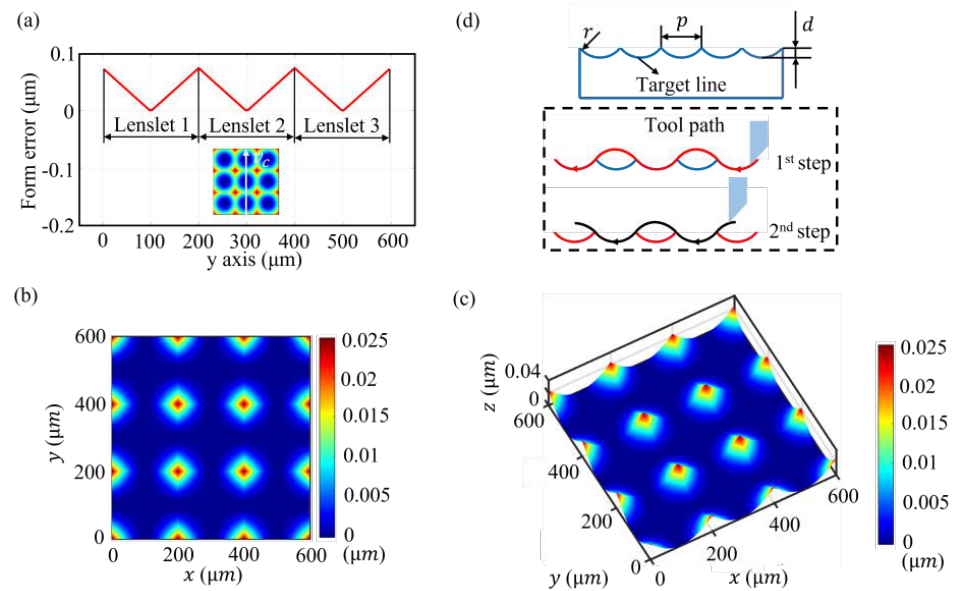
Figure 5. Theoretical form error in HFUVAS of microlens array induced: ( a ) by overcut of vibration, ( b , c ) by overcut of tool edge, ( d ) smooth tool path generation of the target line.